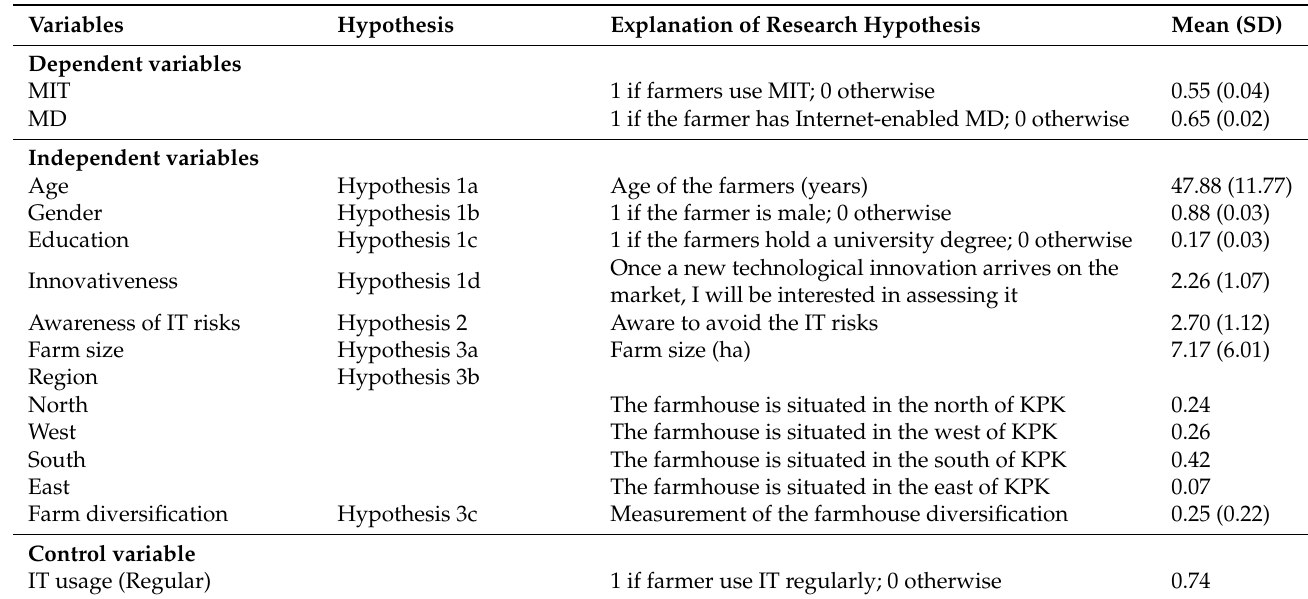
Table 1. Variables descriptions and descriptive